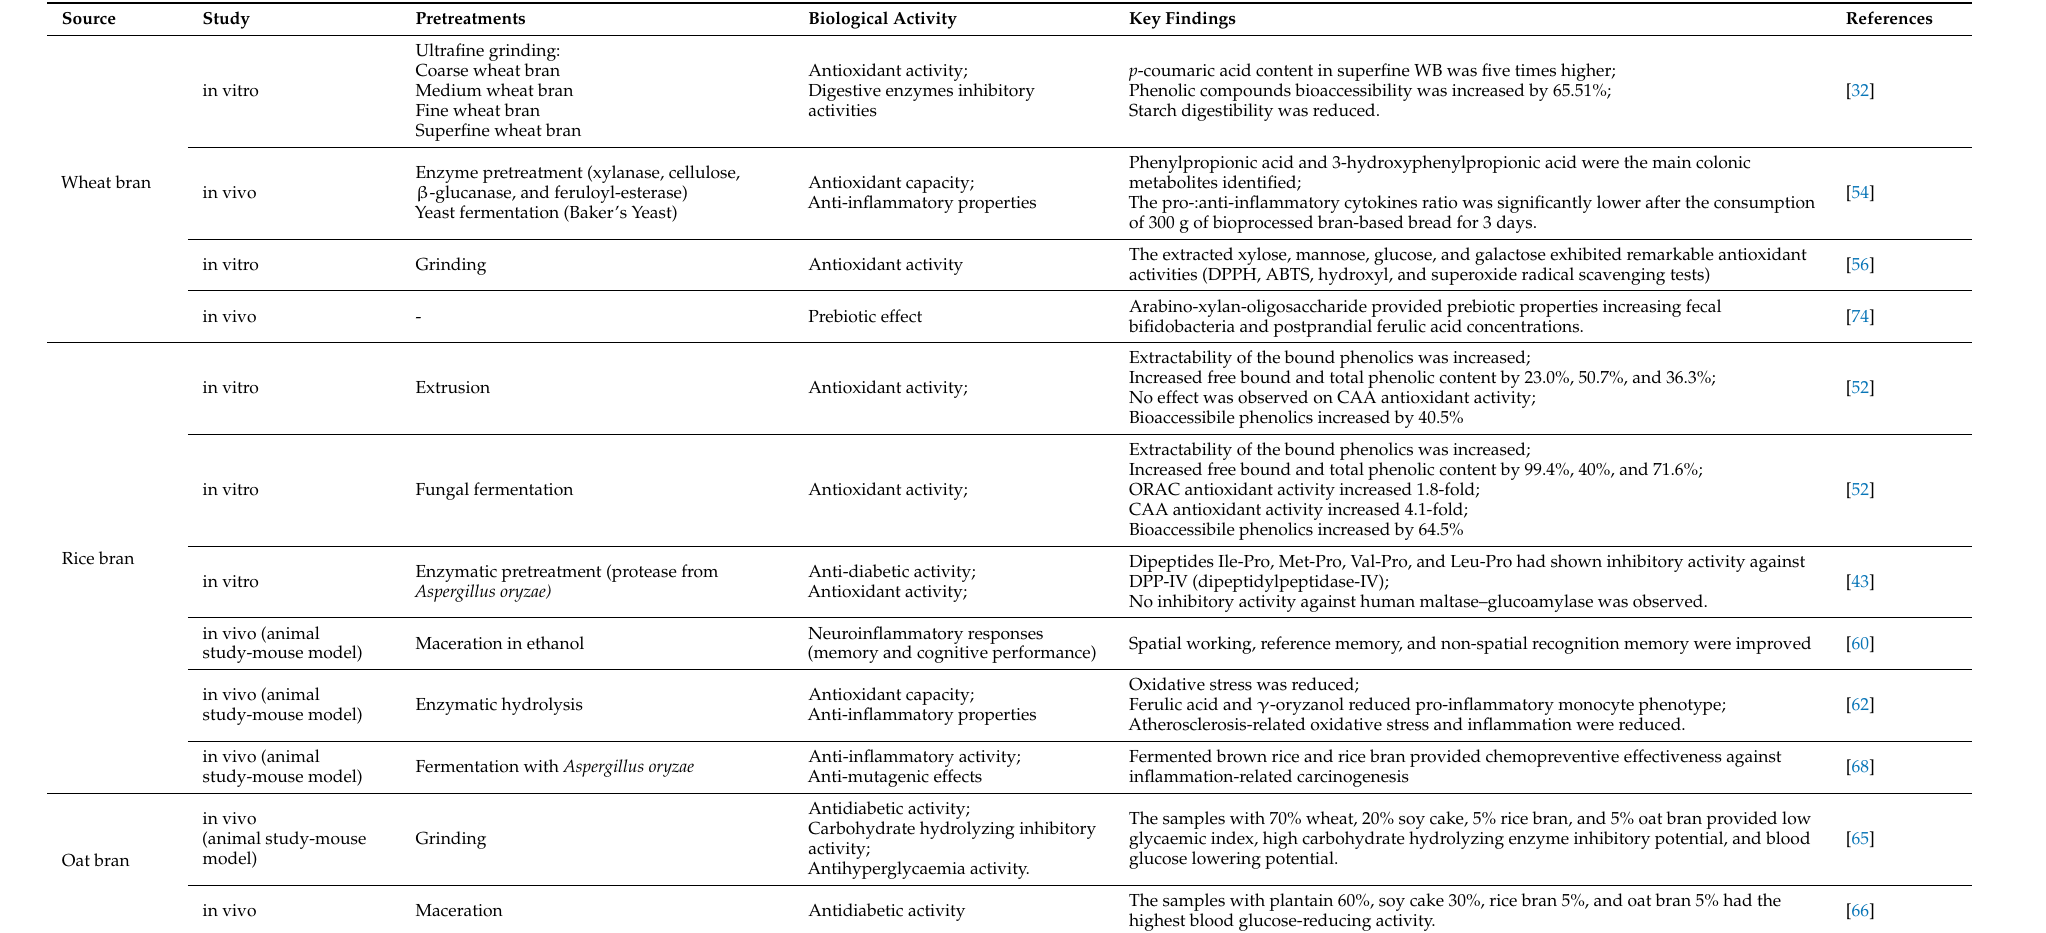
Table 2. Biological activities of wheat bran, rice bran, and oat